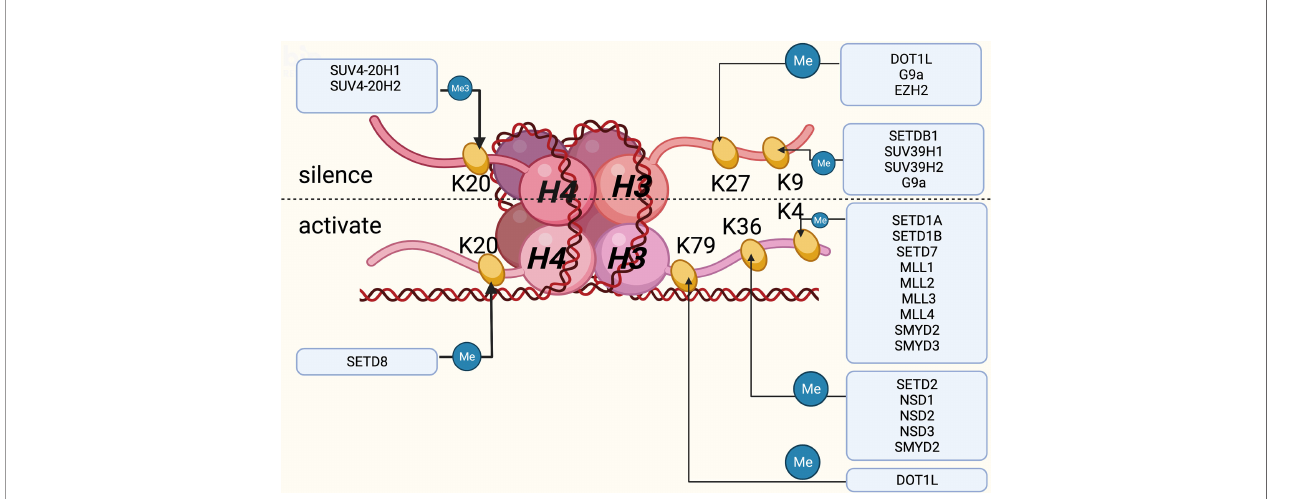
FIGURE 1 | Histones and the DNA wound around the histones together constitute the nucleosomes, which are the main structural elements of chromatin, mainly composed of H2A, H2B, H3 and H4. Histone lysine methylation occurs mainly at H3 and H4, of which six sites are currently well studied. This fi gure summarizes the role of lysine methylation activation or inhibition at these six sites and the frequently regulated enzymes for them. Created with